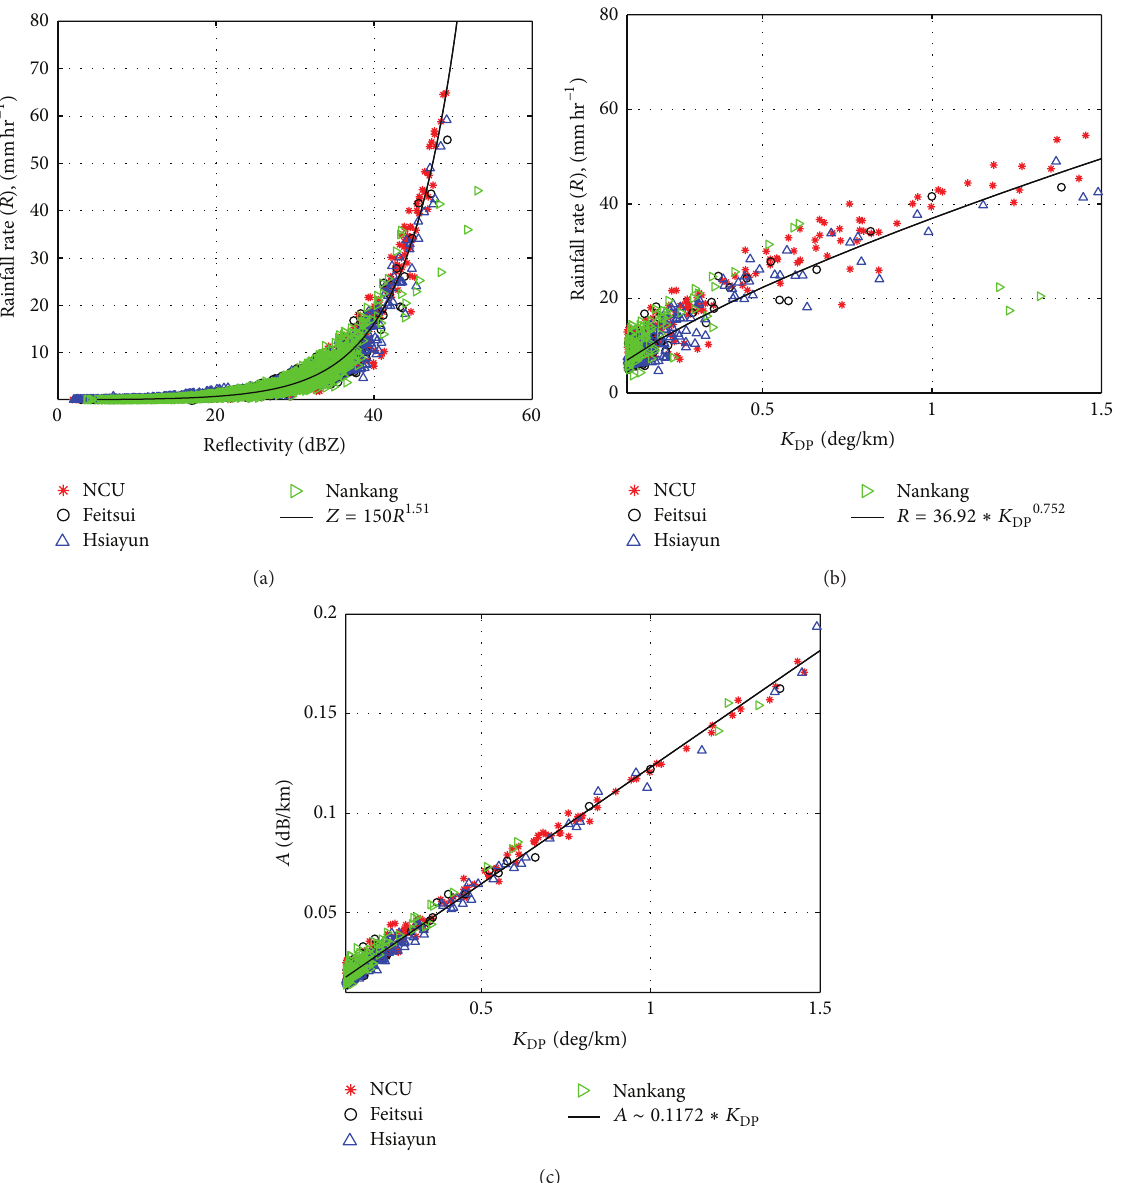
Figure 5: Scatter plot of (a) 𝑍 versus 𝑅 , (b) 𝐾 red: NCU, black: Feitsui, blue: Hsiayun, and green: Nankang. The polynomial fitted results are inserted as black